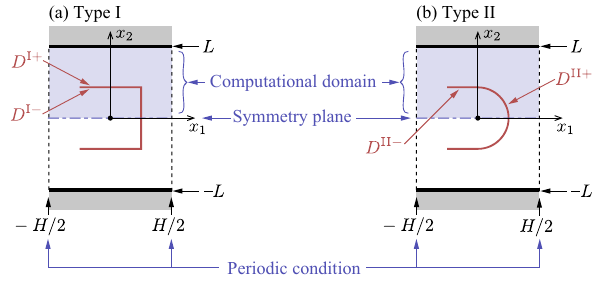
Figure 3. The computational domains in the basic unit for ( a ) type I and ( b ) type